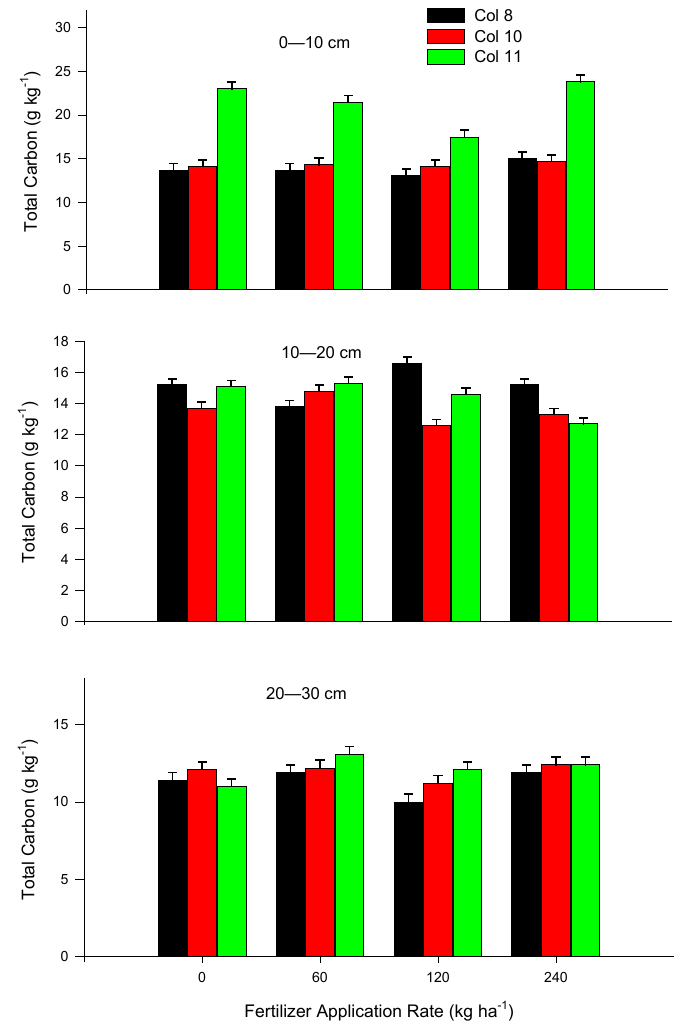
Figure 2. Total carbon variation with soil depths for three tillage techniques.